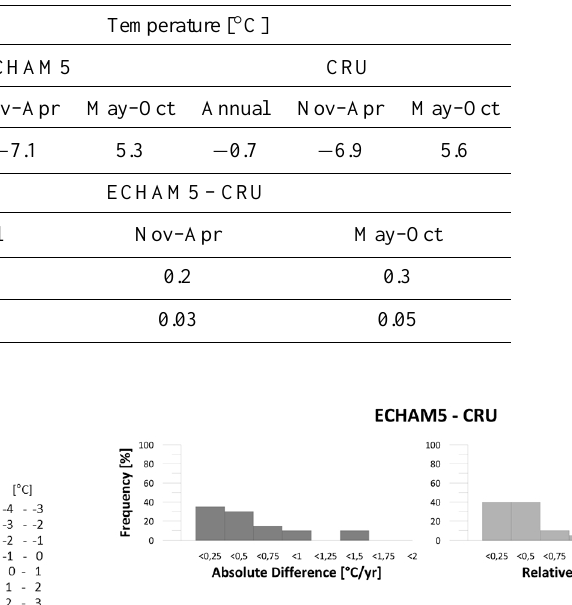
Fig. 3. Frequency distribution of absolute and relative differences in mean temperature of from ECHAM5 and CRU for the period 1981–2004.